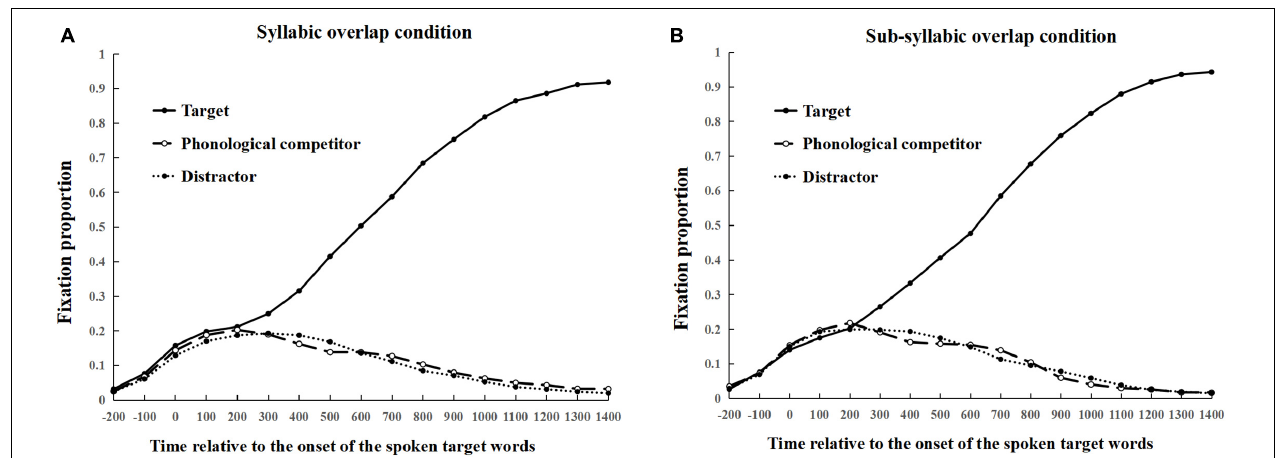
FIGURE 2 | Proportion of fixations on the target, the phonological competitor and the distractors from 200 ms before the onset of the spoken target word in the syllabic overlap condition (A) , and sub-syllabic overlap condition (B) , respectively in Experiment 1.